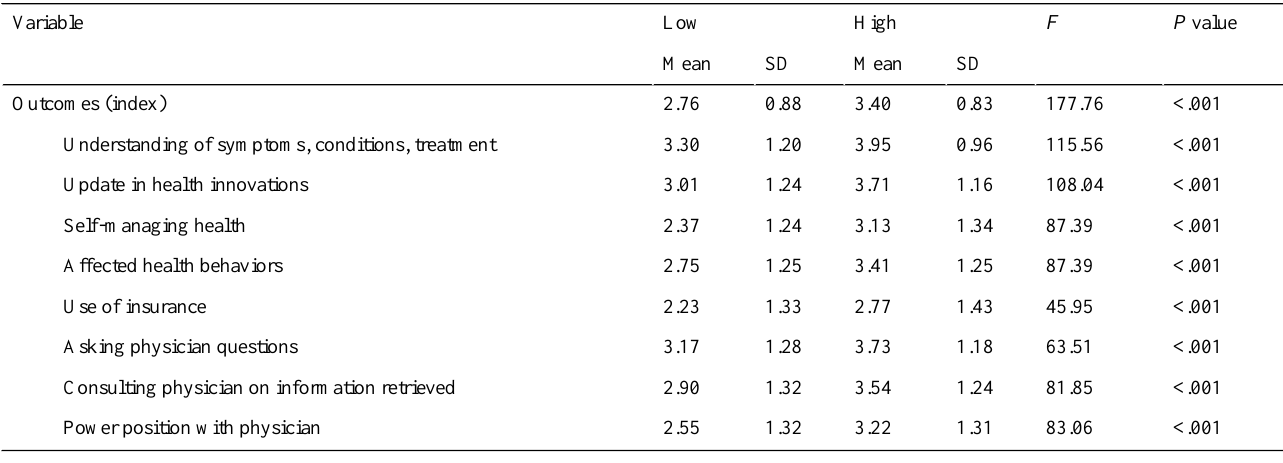
Table 2. Scores for low and high eHealth literacy groups in outcomes of information